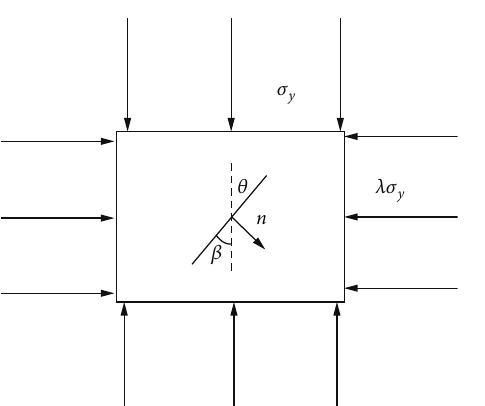
Figure 6: Schematic diagram of expansion of compression tensile shear crack